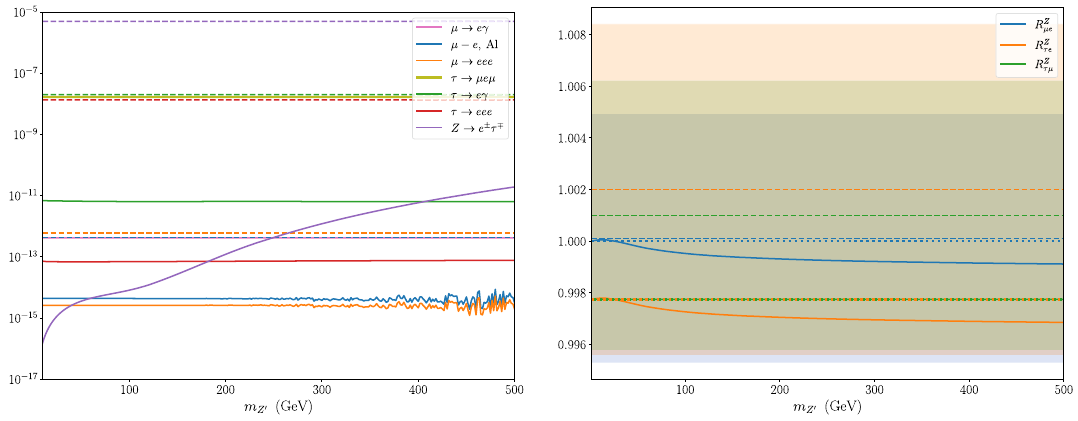
μτ Fig. 9 Fits of g as a function of m Z (cid:2) . In blue (orange), 1 σ estimate of g L , R given m Z (cid:2) . On the right panel, regimes for which the fit is not satisfactory (non-perturbative couplings) are represented in grey